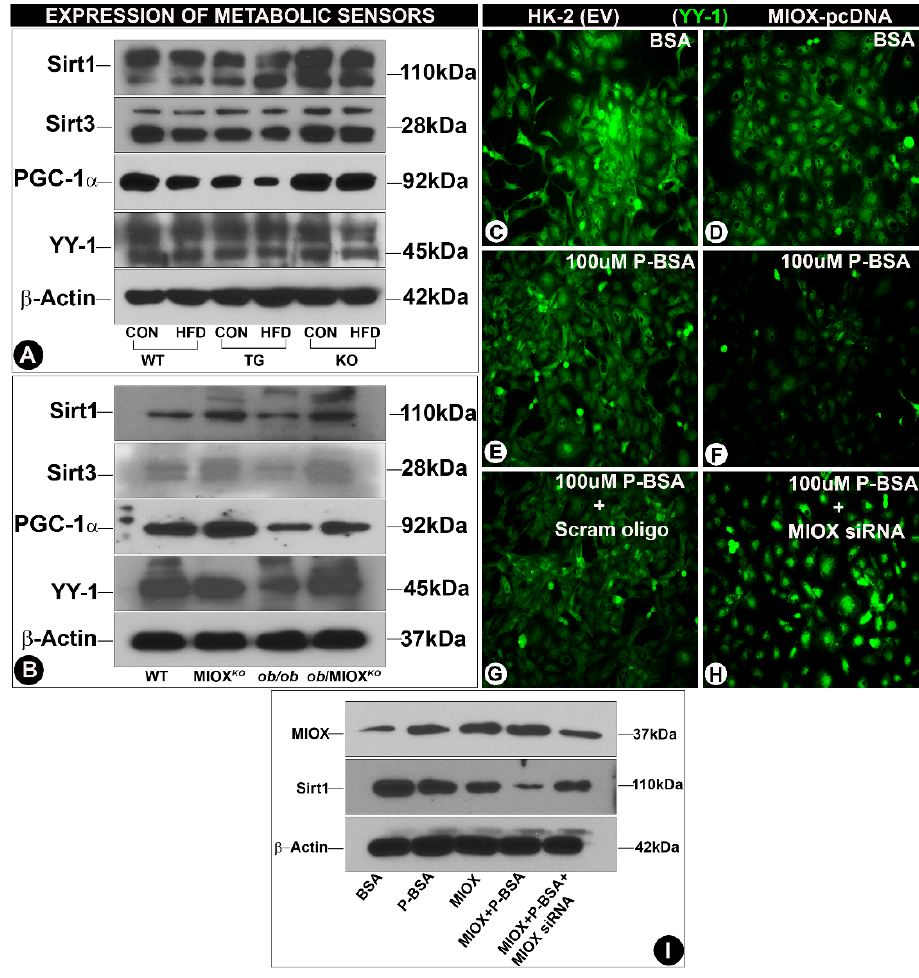
Figure 3. Modulation of expression of sirtuins and transcription factors (PGC-1 α and YY-1) by MIOX. Panels ( A , B ): immunoblotting data indicated a decreased expression of Sirt1, Sirt3 and peroxisome proliferator-activated receptor gamma coactivator 1-alpha (PGC-1 α ) and Ying-Yang1 (YY-1)